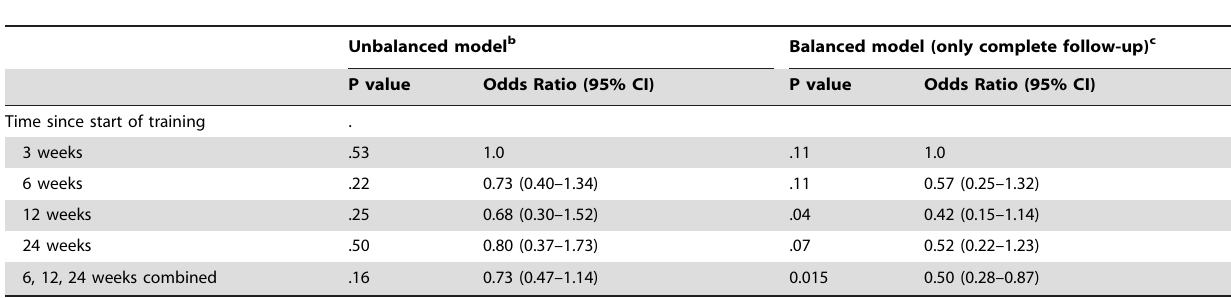
Table 1. Timing of acquisition of pneumococci during training in confined setting in Israel, identified by multivariable repeated measures analysis a